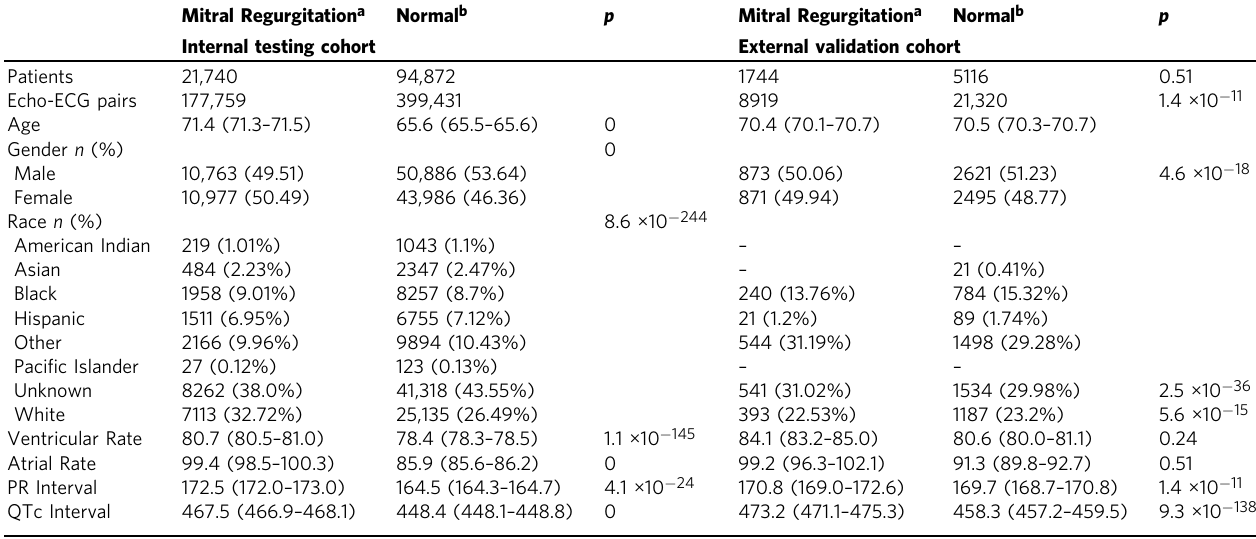
Table 1 Population metrics: patients with Mitral Regurgitation (MR) in internal and external validation cohorts. Mitral Regurgitation a